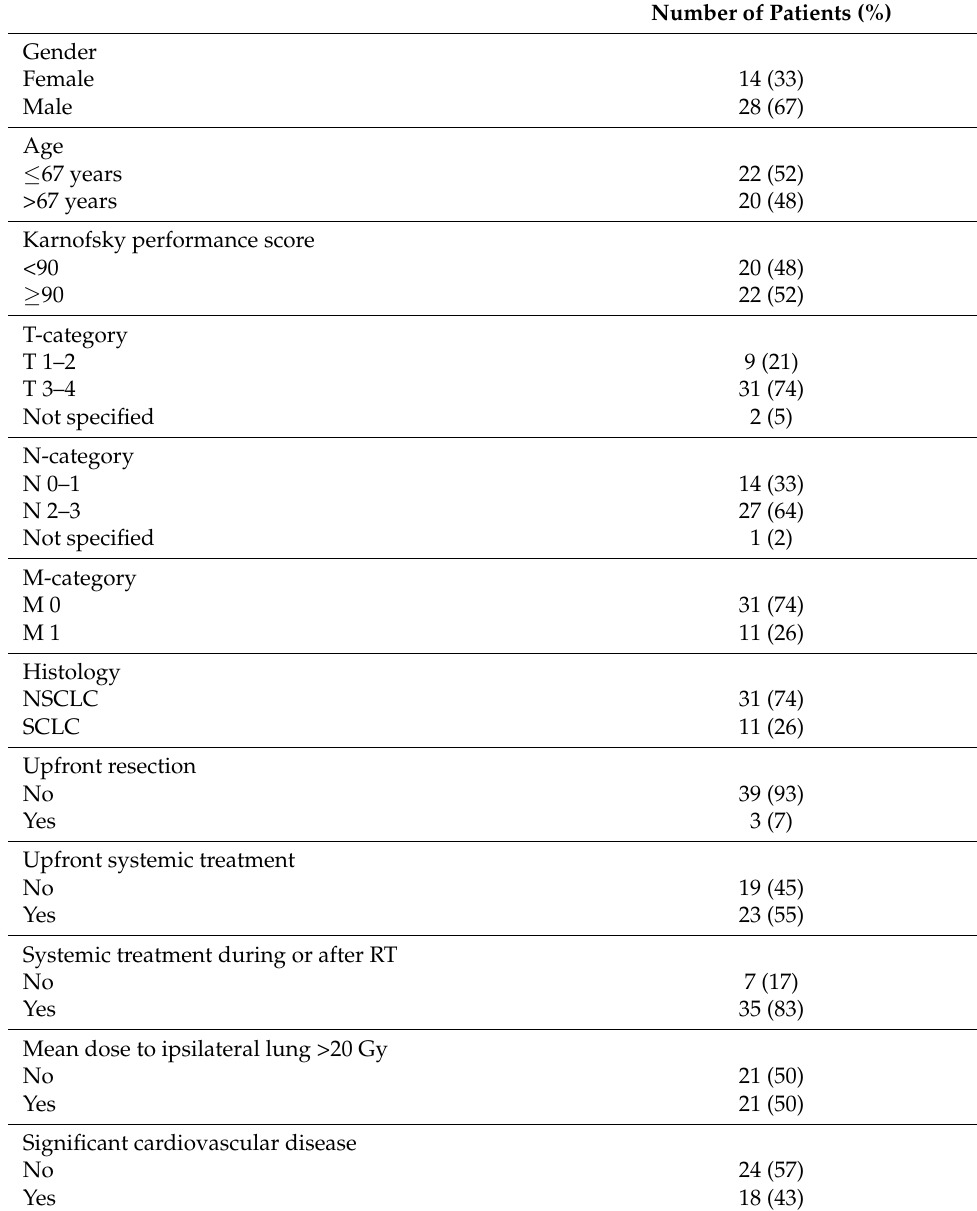
Table 2. Characteristics of the 42 patients eligible for the primary endpoint (evaluation of presence or absence of radiation